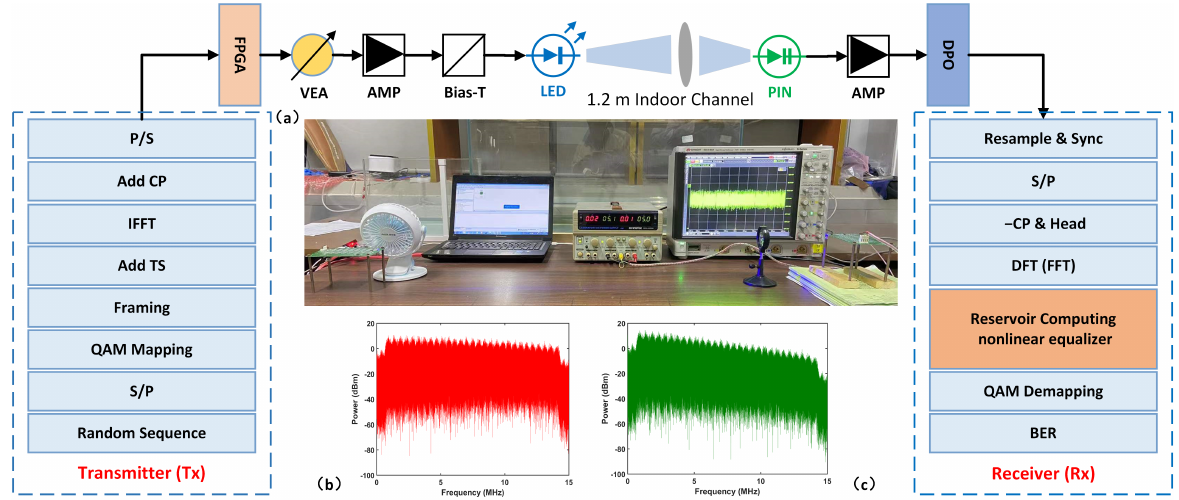
Figure 2. System structure diagram: ( a ) The experimental bench; ( b ) the transmitted spectra of the transmitter; ( c ) the received spectra of the